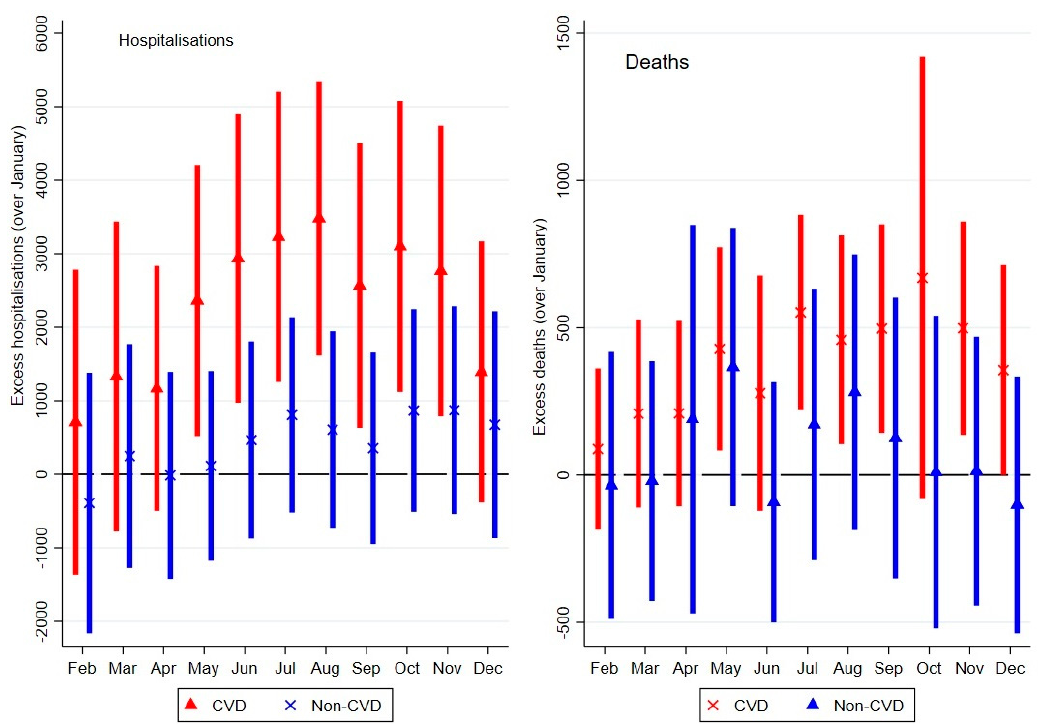
Figure 2. Excess monthly CVD- and non-CVD-related events.